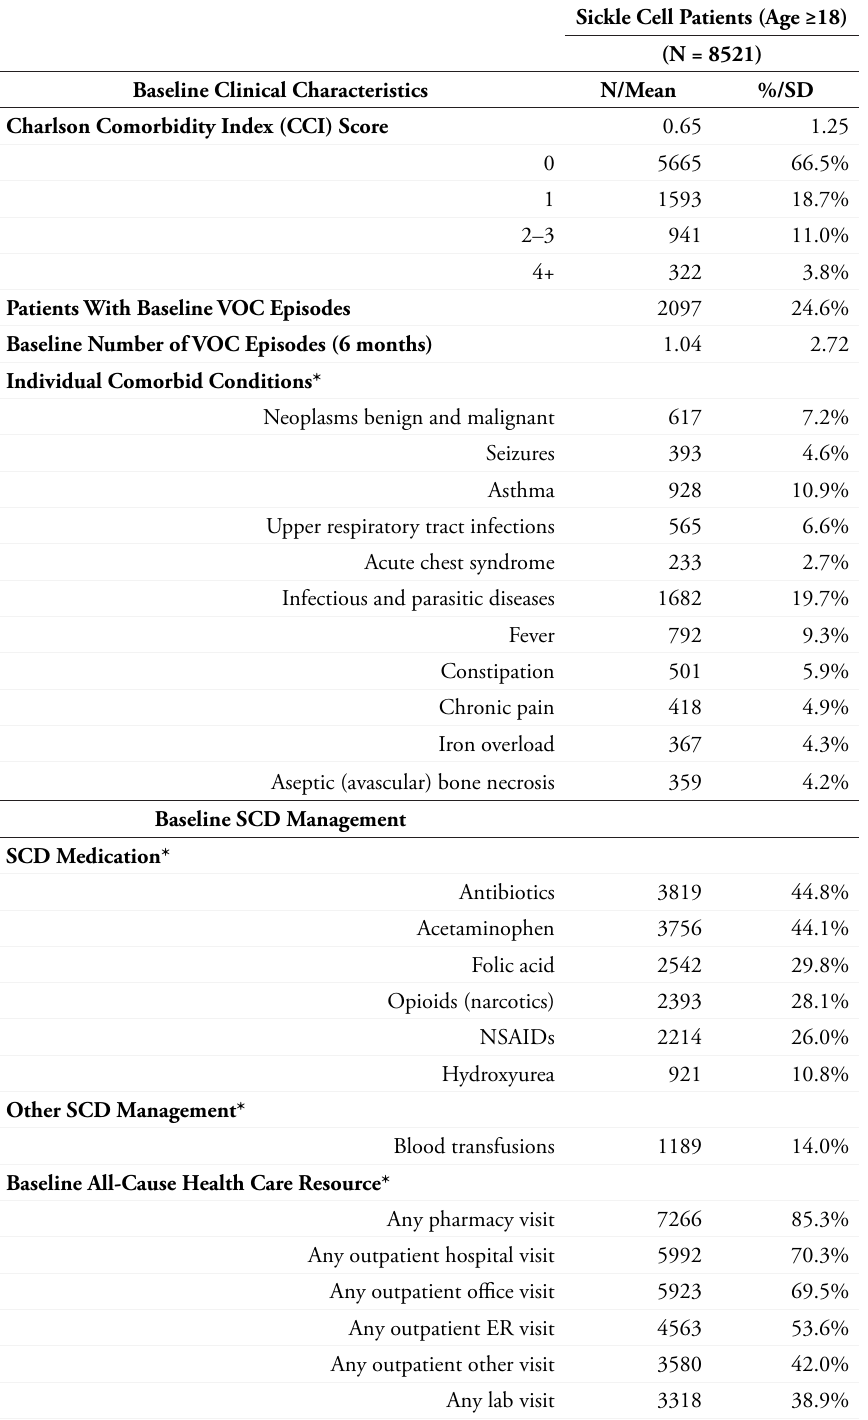
Table 2. Baseline Clinical Characteristics and